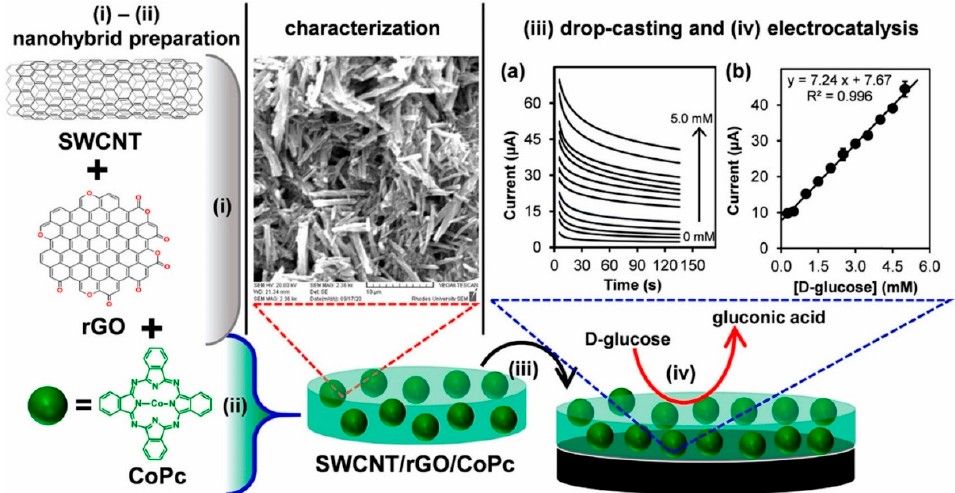
Figure 7. (i,ii) Nanohybrid preparation: SWCNT was modified with reduced graphene oxide (which was prepared by Improved Hummers Method) and cobalt phthalocyanine. The SEM image corresponds to SWCNT/rGO/CoPc nanohybrid. (iii) Fabrication of sensing electrodes (glassy carbon electrode or GCE) by drop-casting method. (iv) Electrochemical oxidation of D-glucose to gluconic acid. (a) Static chronoamperogram response of GCE-SWCNT/rGO/CoPc with increasing glucose concentrations from 0 mM to 5.0 mM in 0.10 M NaOH, and (b) the corresponding calibration plot of steady-state current against concentrations of glucose.. Image reproduced with permission from [182]. Copyright 2021 Elsevier.